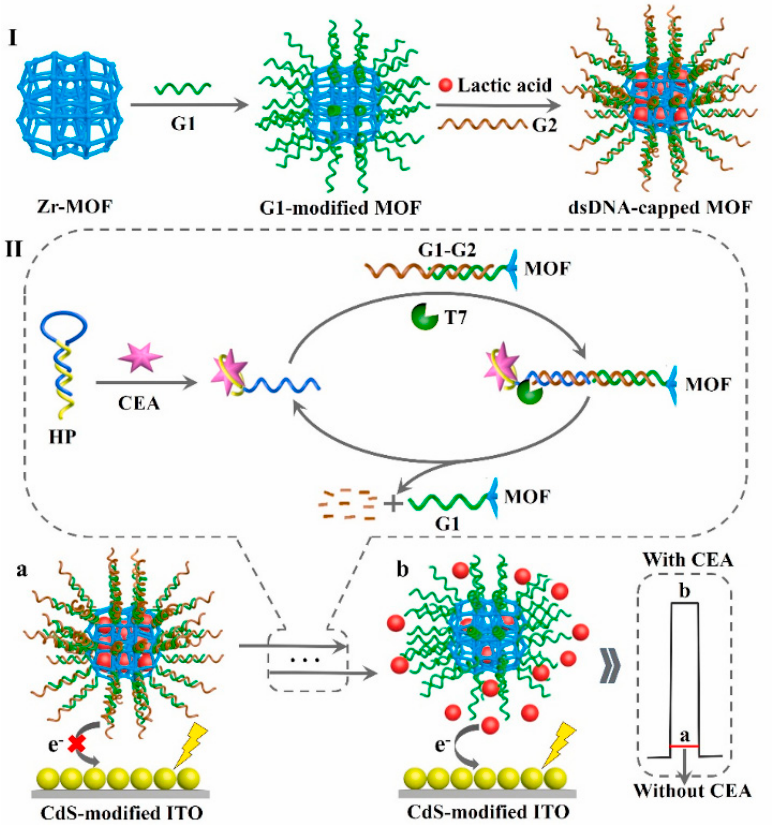
Figure 11. Schematic illustration of the proposed PEC biosensor for CEA determination. Reprinted with permission from ref. [127]. Copyright 2021 Elsevier.